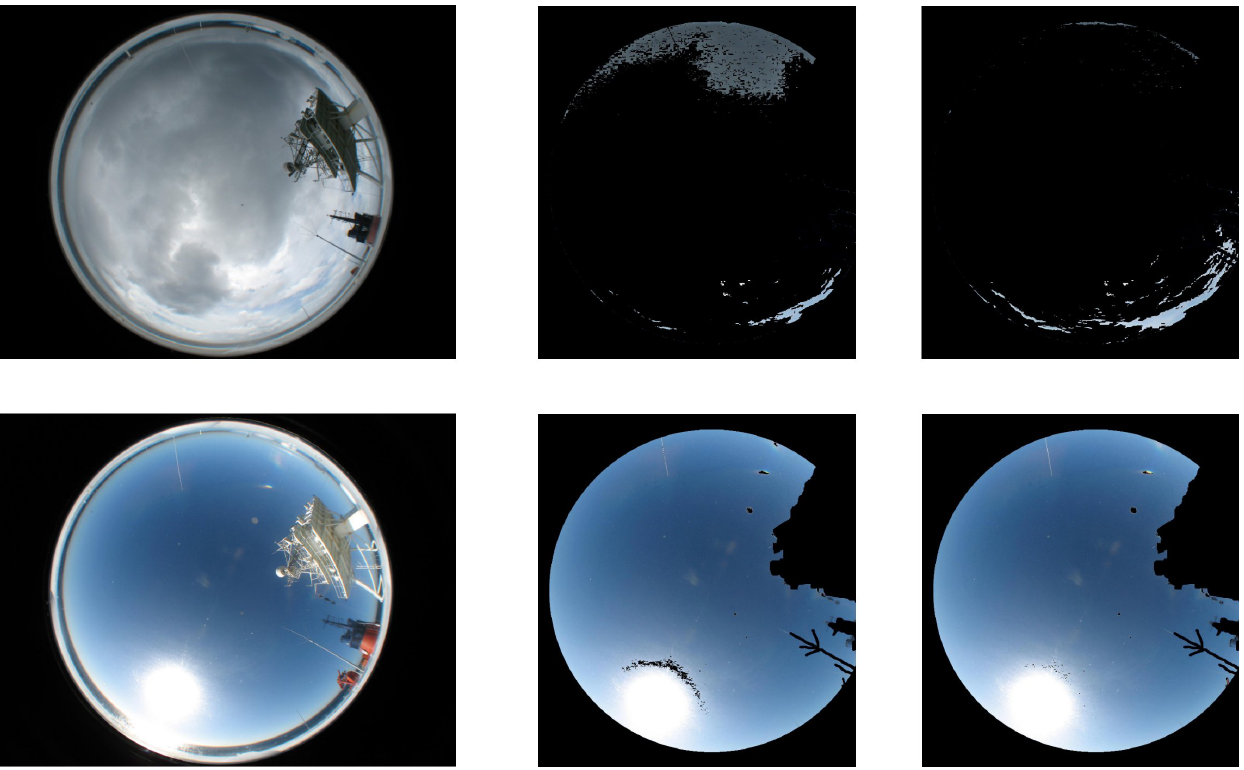
Fig. 2. Segmentation for optical thick clouds (top) and clear sky (bottom) using a treshold of R/B = 0 . 8 (middle) and a treshold of R − B = 30 (right).